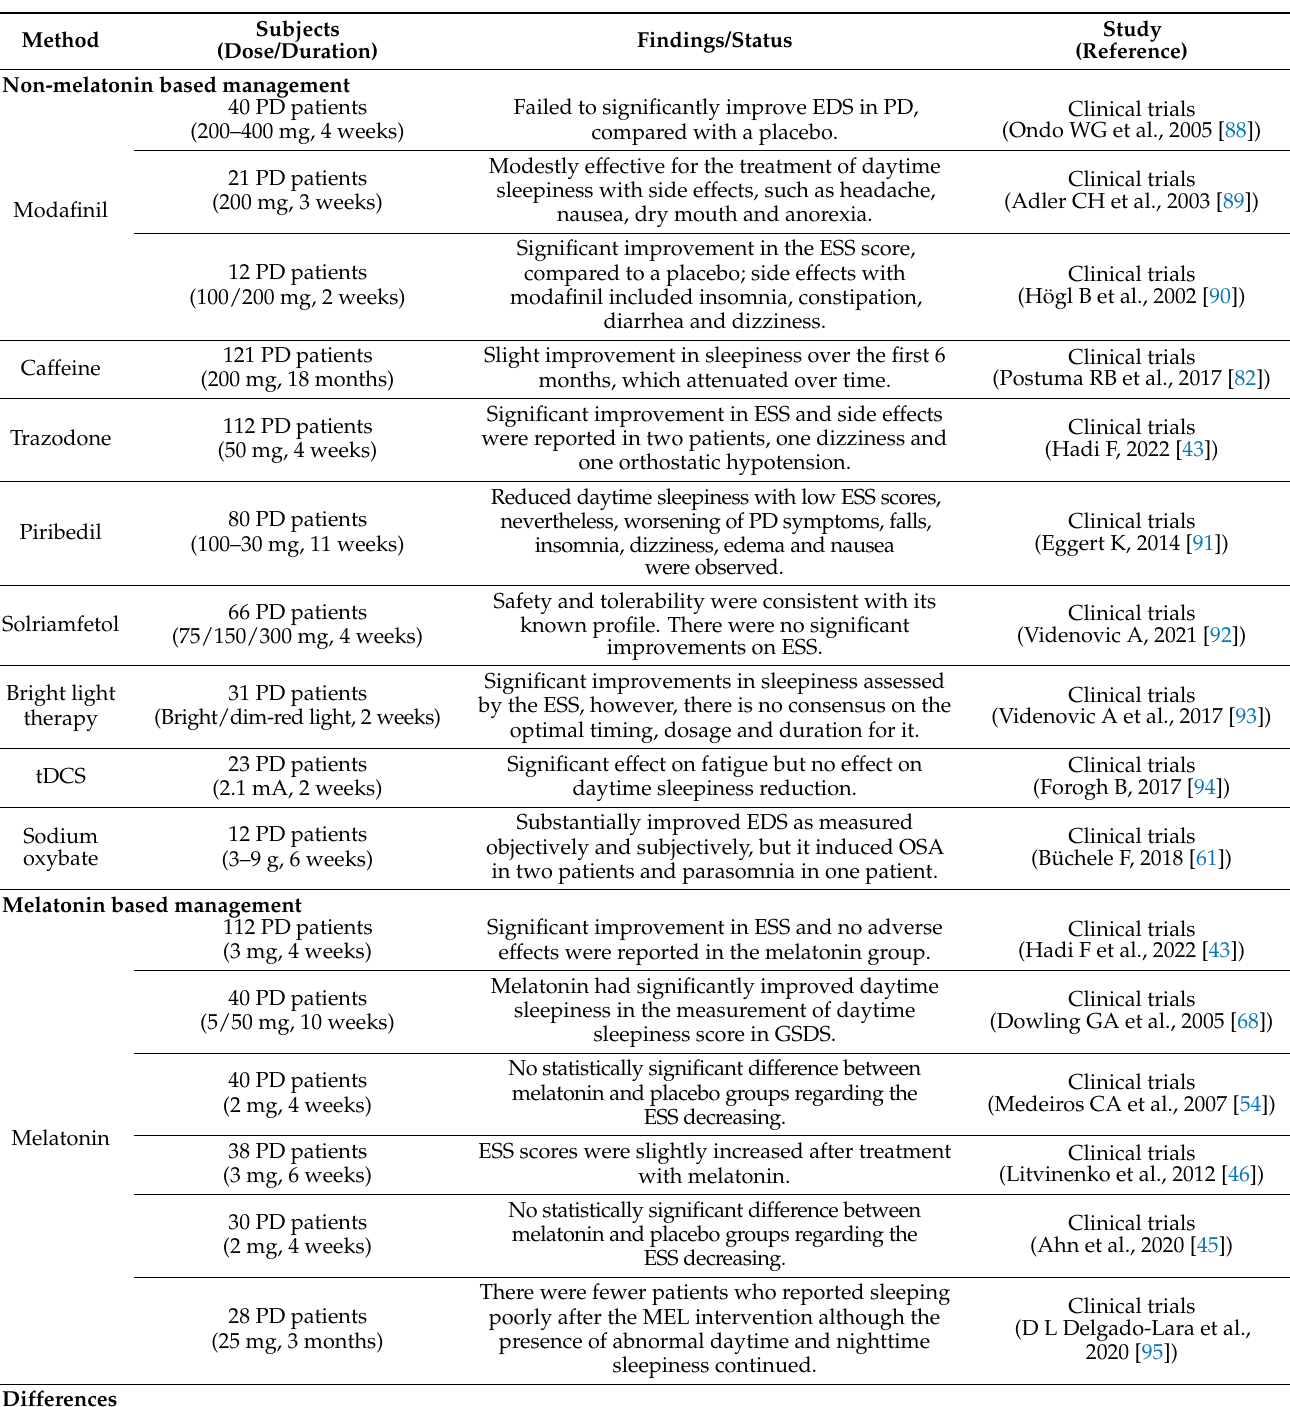
Table 4. EDS in Parkinson’s disease and their management supported by randomized controlled